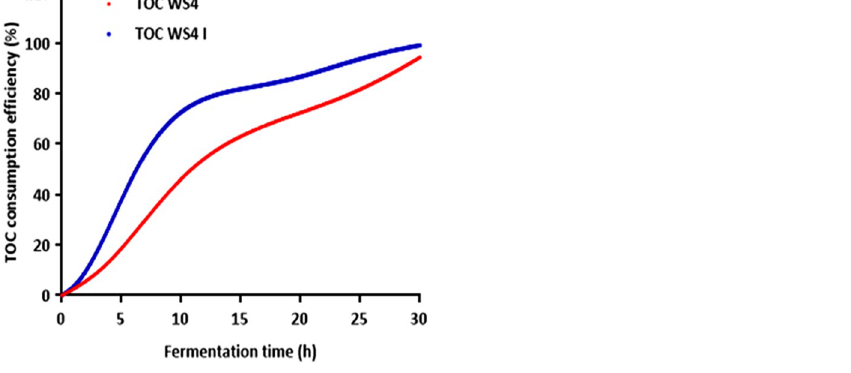
Figure 5. TOC consumption efficiency during P. temperata fermentation in WS4 and WS4 I.